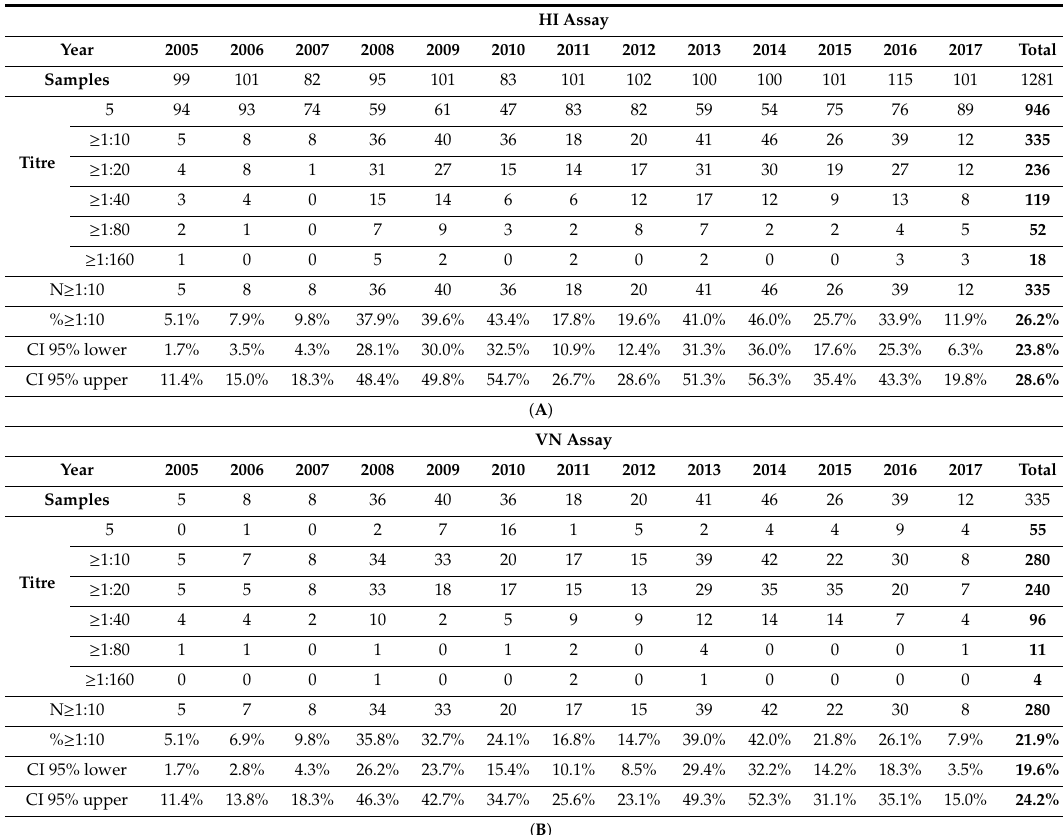
Table 2. IDV specific HI (A) and VN (B) titres of human serum samples collected from 2005 to 2017 in Italy.